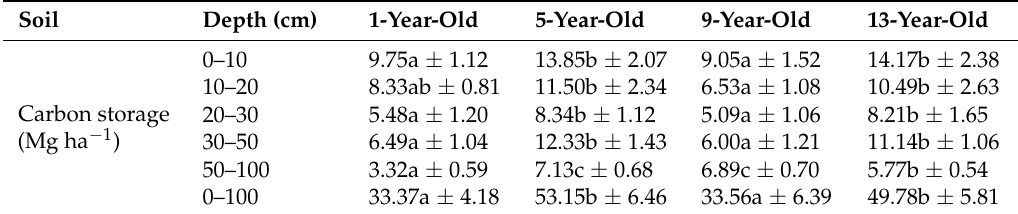
Figure 2. Soil carbon content in different depths in J. regia plantations of four different ages. Note: Error bar indicates S.E. Table 5. Soil carbon storage (Mg ha − 1 ) in different depths in 1-, 5-, 9-, and 13-year-old J. regia plantations ( n =